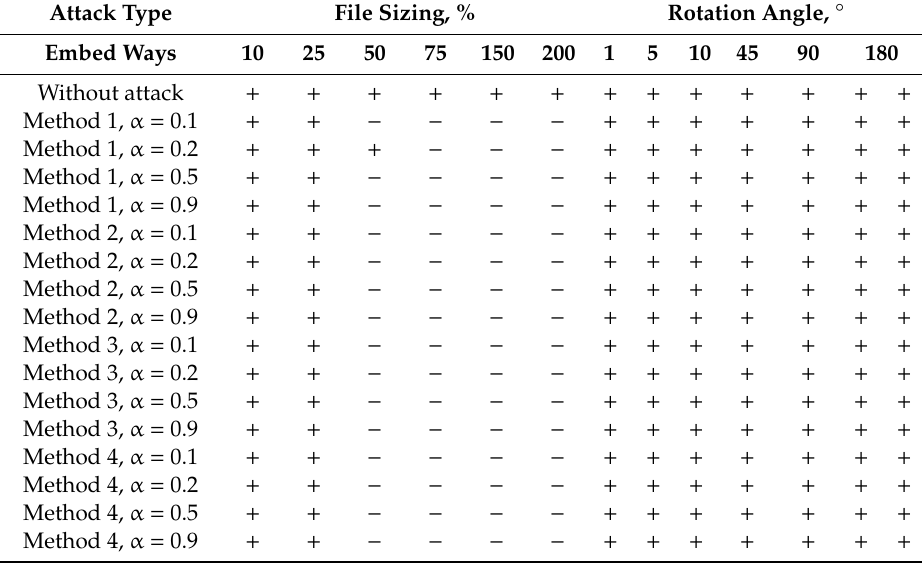
Table 3. The results of the experiments carried out on the attacks to verify the e ff ectiveness of the method on the example of the test image “Lena” by Equation (34) for the parameters m = 1 / 3, n = 1.